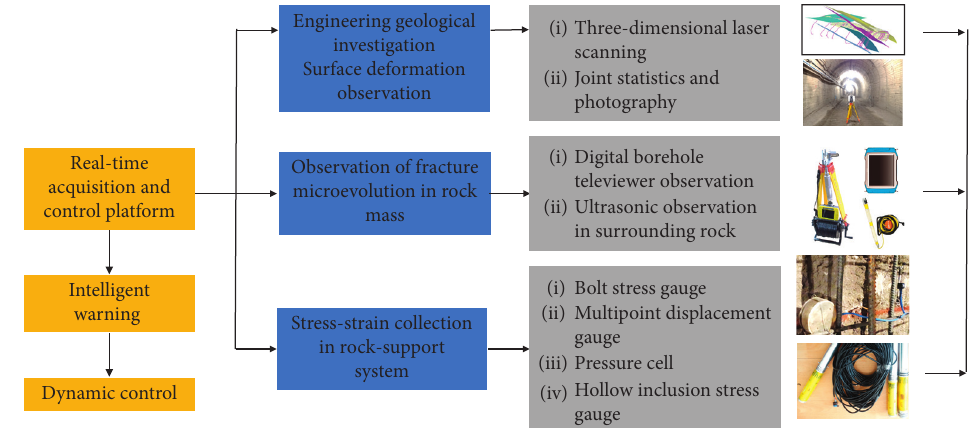
Figure 4: Intelligent monitoring system for large deformation.